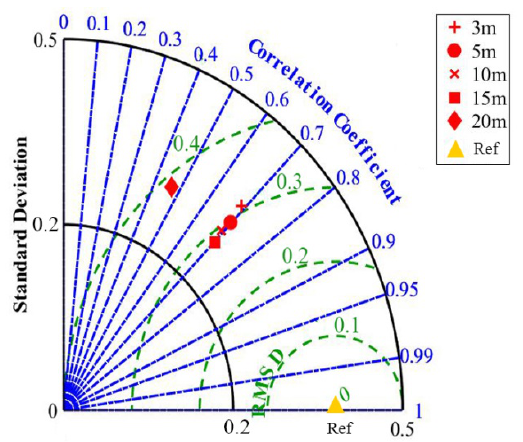
Figure 9. Taylor chart of LiDAR sampling sensitivity analysis. The histogram of the ACI frequency distribution obtained from vertical transects and horizontal transects for the paired samples introduced in Section 2.5.3 is shown in Figure 10. Subsequently, the paired-sample Kruskal–Wallis test result between the vertical and hori- zontal transect ACI differences was significant (chi-squared = 7.8476 > 6.635, p -value < 0.01). This finding indicated that there was a significant difference between the ACI values extracted from the vertical and horizontal transects within the same paired